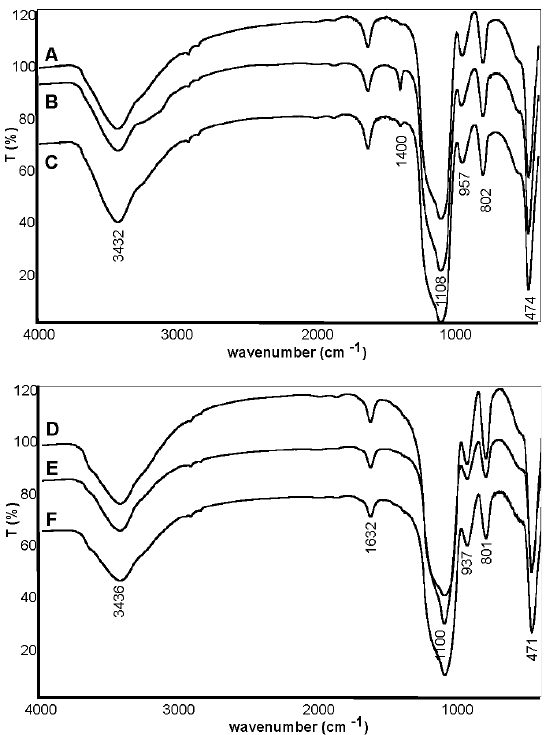
Figure 2. The FT-IR spectra of the studied silica materials A – F. The elemental analysis was also determined for all of the silica samples (A – F). In the samples A – C synthesized according to procedures 1 – 3, respectively, trace amounts of ni- trogen (0.16, 0.57, and 0.18 wt.%, respectively) were estimated, which indicated the re- maining ammonia in the carriers. In contrast, the samples D – F did not show nitrogen, indicating that the grinding process removed the ammonia. The scanning electron microscope (SEM) images show a considerable influence of the method synthesis on the morphology of silica materials (Figure 3). The presented samples showed irregular and very porous structures. The tendency of silica nanoparticles to ag- gregate can be seen, especially for the materials D – F obtained by grinding. The SEM im- ages of silica nanoparticles A – C indicate their spherical shape. Grinding leads to partial destruction of spherical particles and increases the porosity of the surface (specific surface area and pore size).